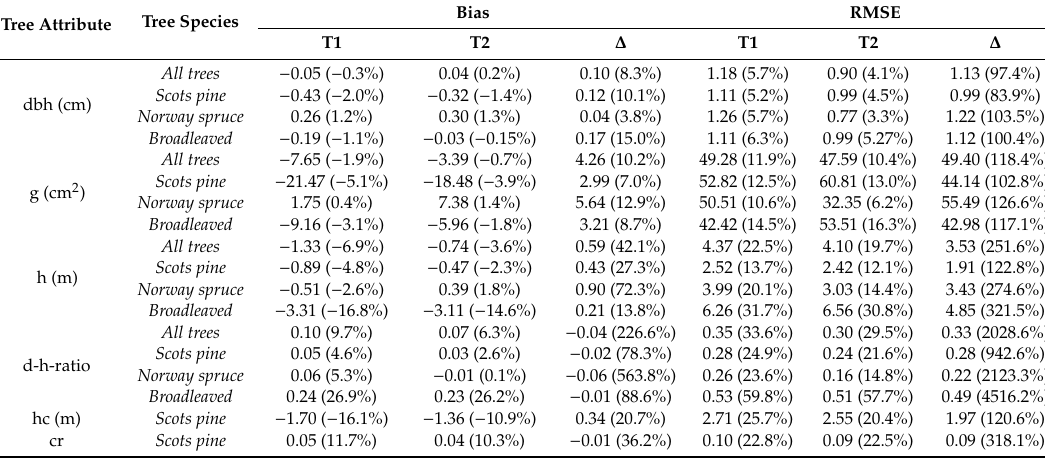
Table 4. Bias and root-mean-square-error (RMSE) of TLS-derived estimates for tree attributes, namely diameter-at-breast-height (dbh), basal area (g), tree height (h), diameter-height-ratio (d-h-ratio), height of the crown base (hc) and crown ratio (cr) by tree species at time points T1 (2014) and T2 (2019) as well as their change ( ∆ ). Negative bias denotes